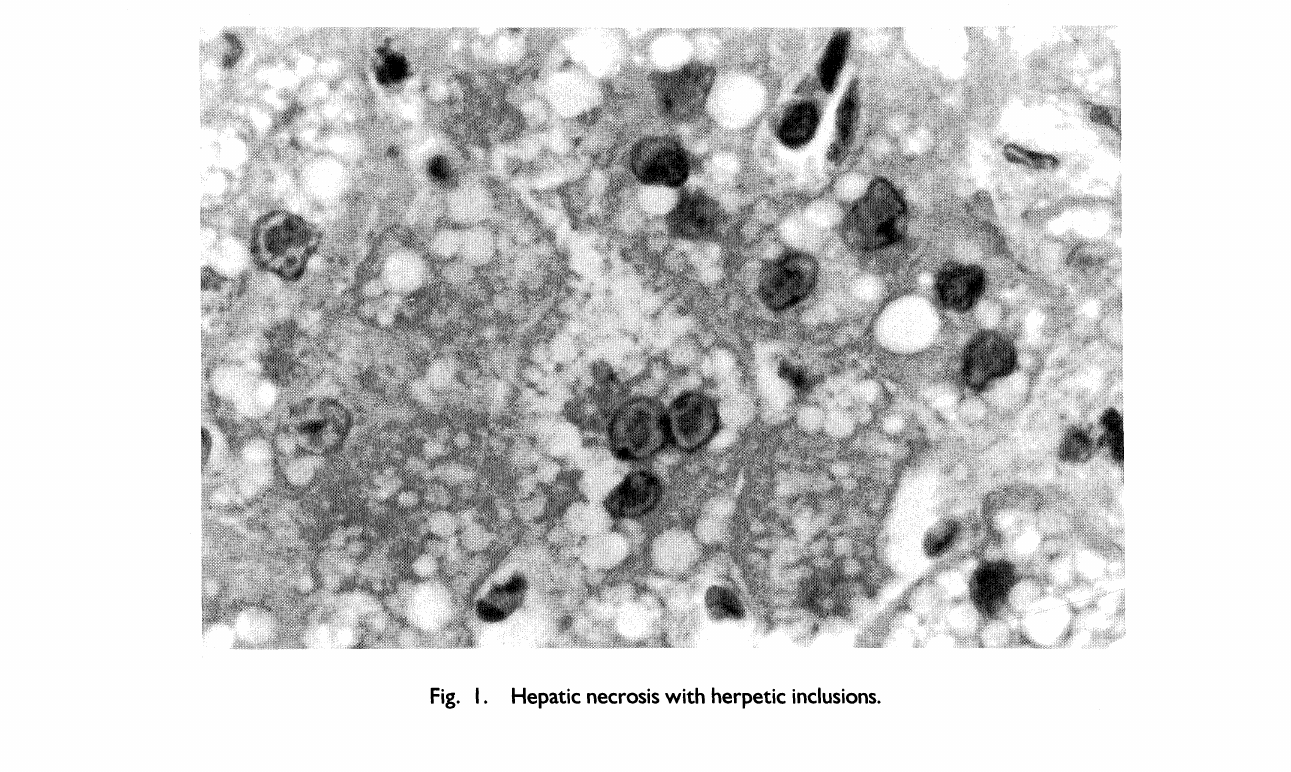
Fig. I. Hepatic necrosis with herpetic